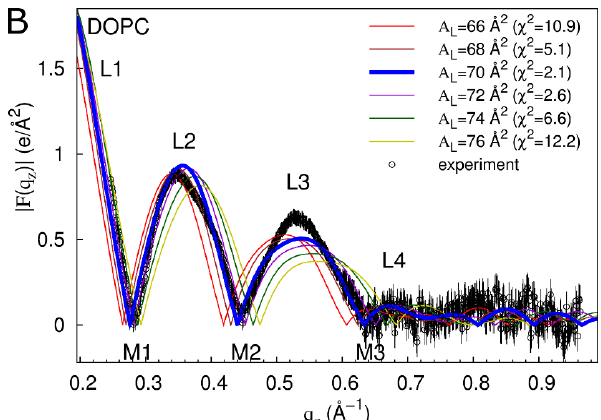
Figure 1. Form factors of neat bilayers from experiment and simulation. |F(q z )| based on out-of-plane scattering intensities from experiment are compared to the computed |F(q z )| from simulations at different values of A L ( χ 2 values in parentheses) for DOPC:DOPE (1:1) ( A ) and DOPC ( B ). Out-of-plane scattering lobes (L) and minima (M) are numbered. Experimental data are averaged over three ( A ) and four ( B ) experiments. Vertical lines depict experimental error estimates (see Methods). Experimental data were scaled to the simulations at A L = 66 Å 2 ( A ) and A L = 70 Å 2 ( B ) (see Methods). 2.2. Tat 47–57 in DOPC:DOPE (1:1) Bilayers